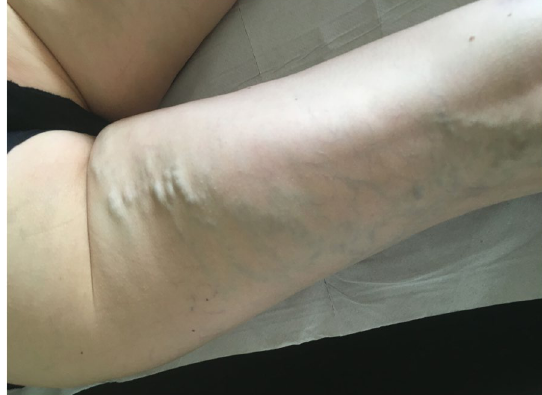
Fig. 1 Posterior thigh varices should raise suspicion of a pelvic source. Prone view of a patient with a characteristic